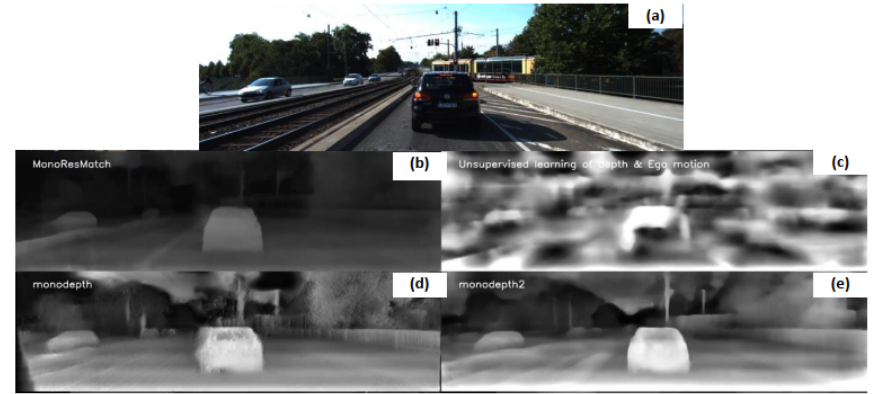
Figure 5. Results of disparity maps obtained using monocular approaches: ( a ) original image; ( b ) MonoResMatch; ( c ) SfmLearner; ( d ) Monodepth and ( e )